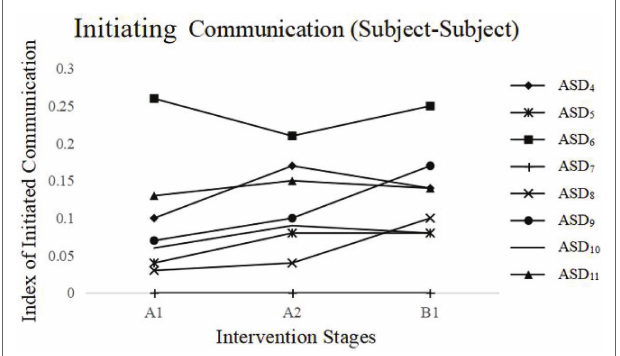
FIGURE 4 | Changes in subject-subject initiating communication in the three intervention stages (Study